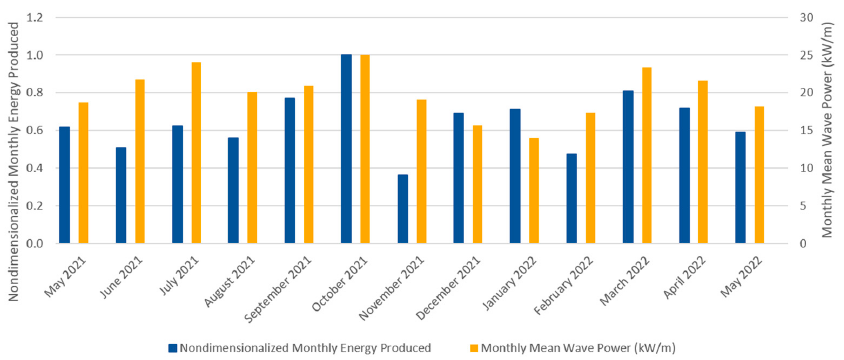
Figure 9. Nondimensionalized monthly energy produced and monthly mean wave power (kW/m) from the start of the operation to June 2022.